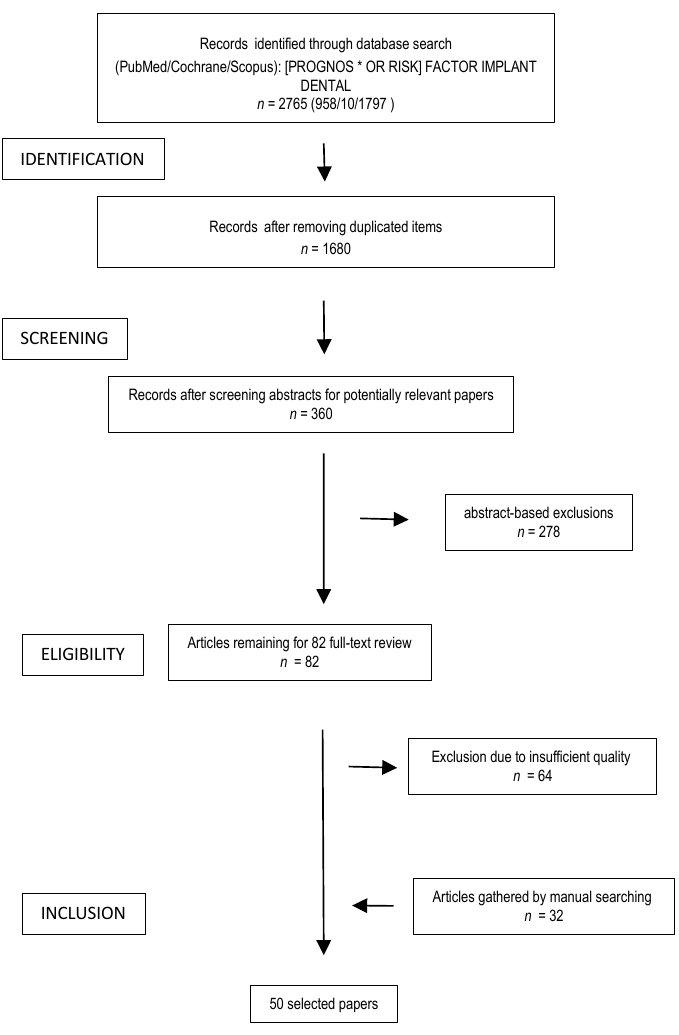
Figure 1. Flow chart of the search strategy of this comprehensive